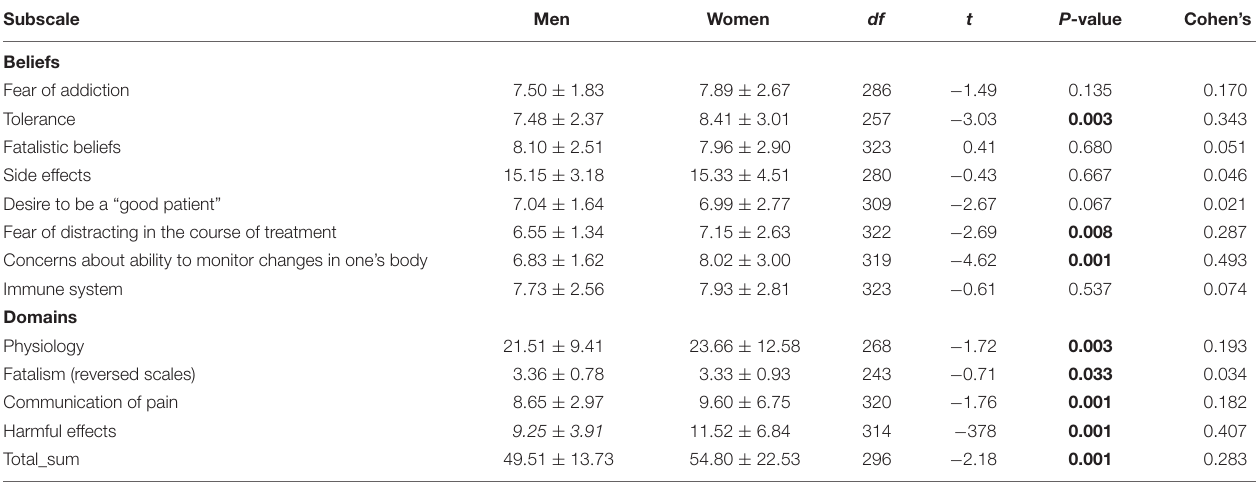
TABLE 2 | Gender differences of mean scores for the BQ-II total scale and subscales. Subscale Men Women df t P -value Cohen’s d